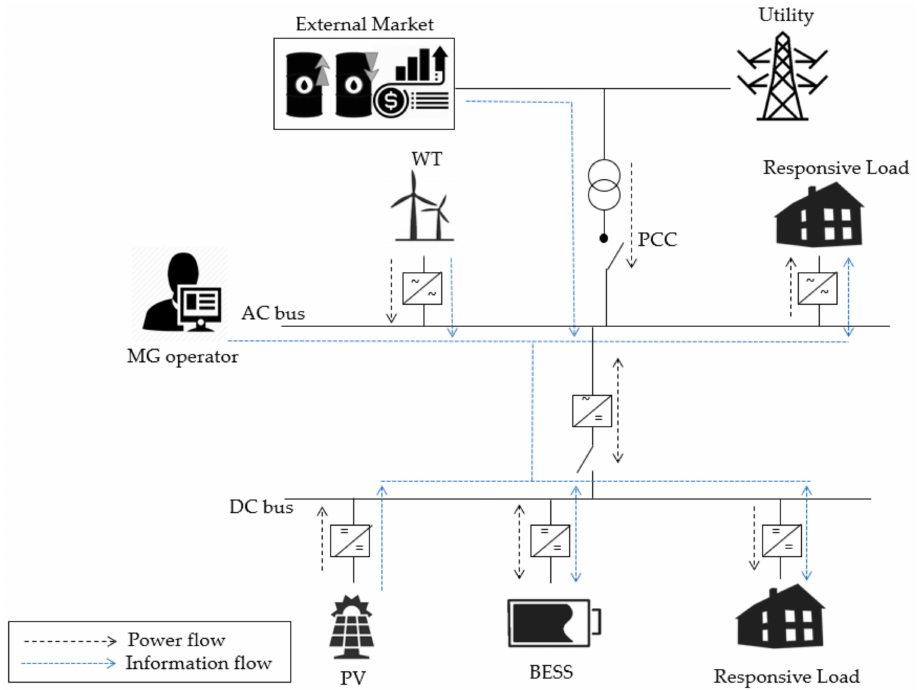
Figure 1. Structure of grid-connected